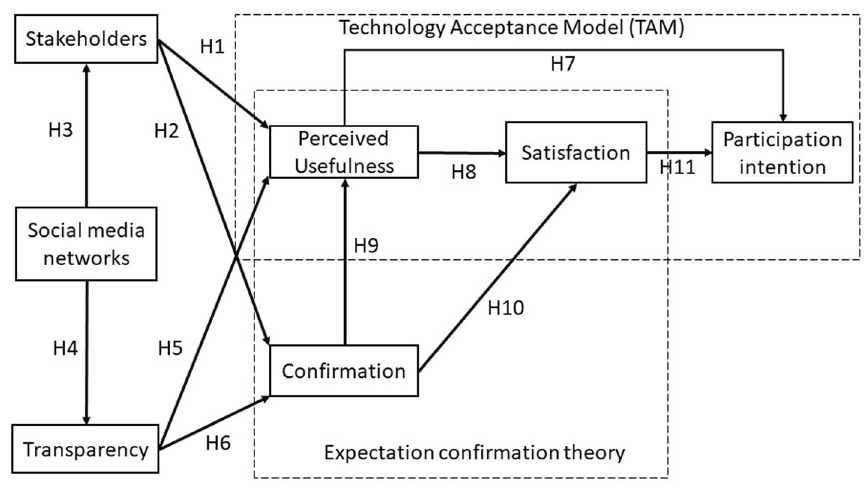
Fig 1. The research